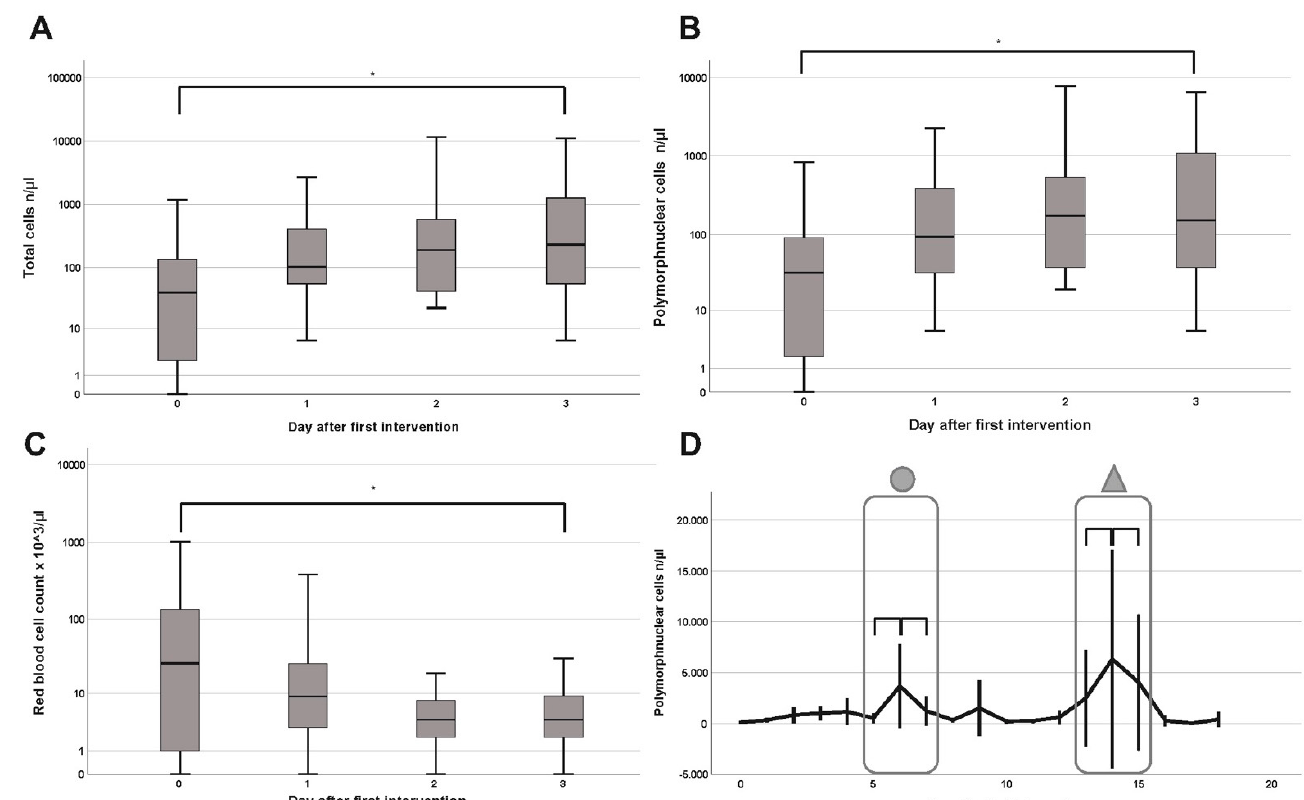
Figure 1. Boxplots of the total cellular amount (n/ µ L) ( A ), polymorphonuclear cells (PMNs) (n/ µ L) ( B ) and red blood cell count (n × 10 3 ) ( C ) on the day of the operation (0) and first to third postoperative day. ( D ) Entire postoperative course of the PMNs (n/ µ L) after the first operation. Encircled areas with a ring or triangle on the top mark intervals of second and third operation, respectively. Vertical bars indicate the 95% confidence interval. The asterisk (*) indicates significance.